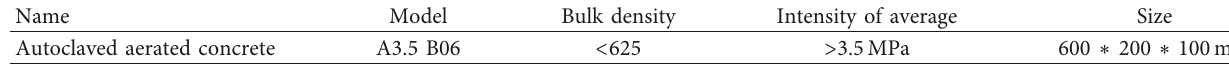
Table 1: Main properties of autoclaved aerated concrete.